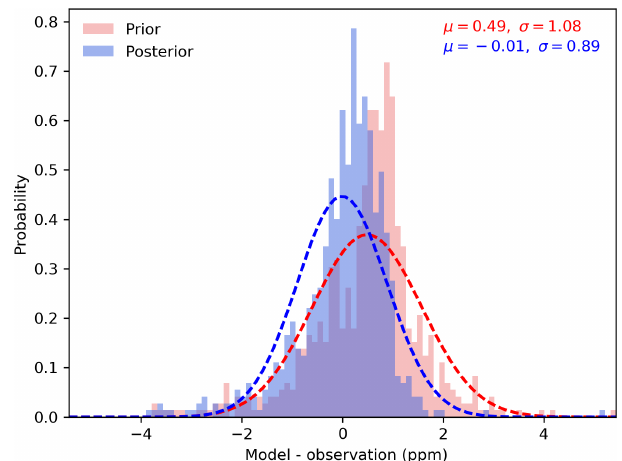
Figure 13. The distribution of the difference between simulated and observed XCO 2 (in ppm). The red histogram presents the prior XCO 2 simulated minus the observed XCO 2 , whereas the blue his- togram presents the posterior XCO 2 simulated minus the observed XCO 2 . Mean differences and standard deviations are indicated in the